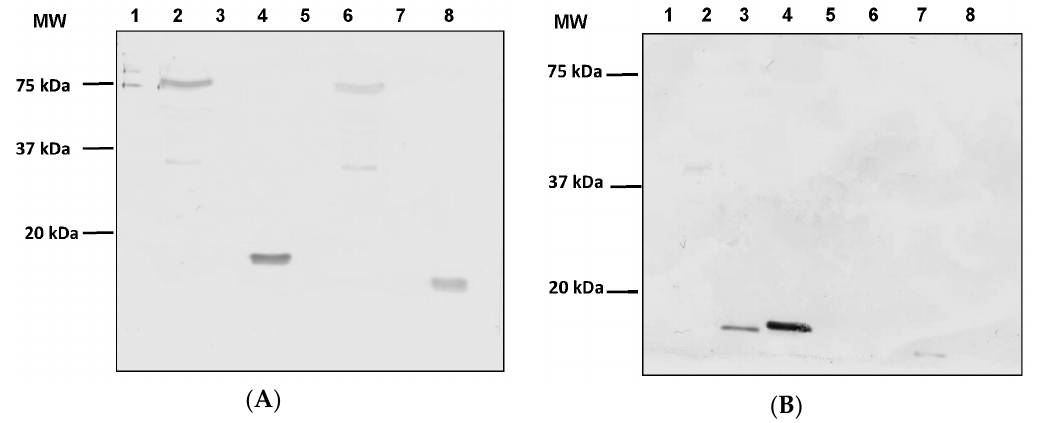
Figure 2. Verification of transgene expression and antigen capsid-incorporation of the modified vectors. ( A ) Western blot analysis confirmed the presence of His 6 incorporation within the modified vectors. The proteins were detected with His 6 MAb. Lane1, Ad5; lane 2, Ad5-CMV-ASP-2; lane 3, Ad5-pIX-ASP-C; lane 4, Ad5-pIX-gp83; lane 5, Ad48; lane 6, Ad48-CMV-ASP-2; lane 7, Ad48-pIX-ASP-C, lane 8, Ad48-pIX-gp83. ( B ) Western blot analysis confirmed the presence of FLAG